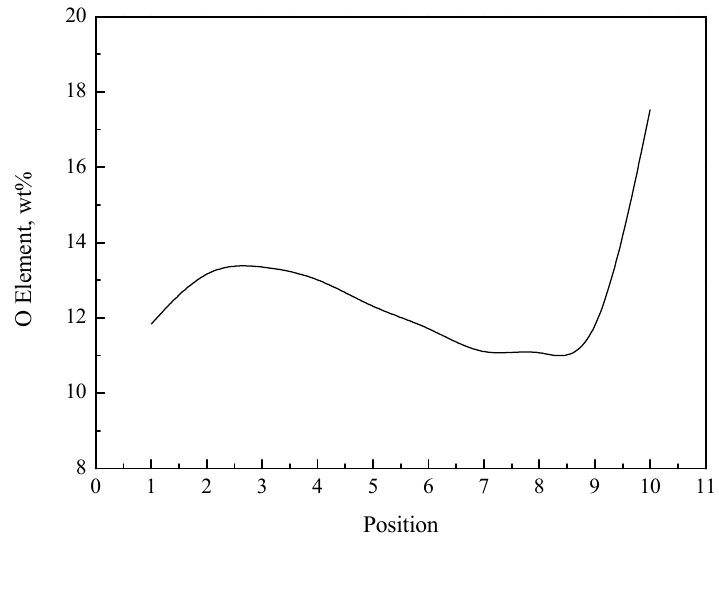
Figure 13. Element analysis of laser radiation